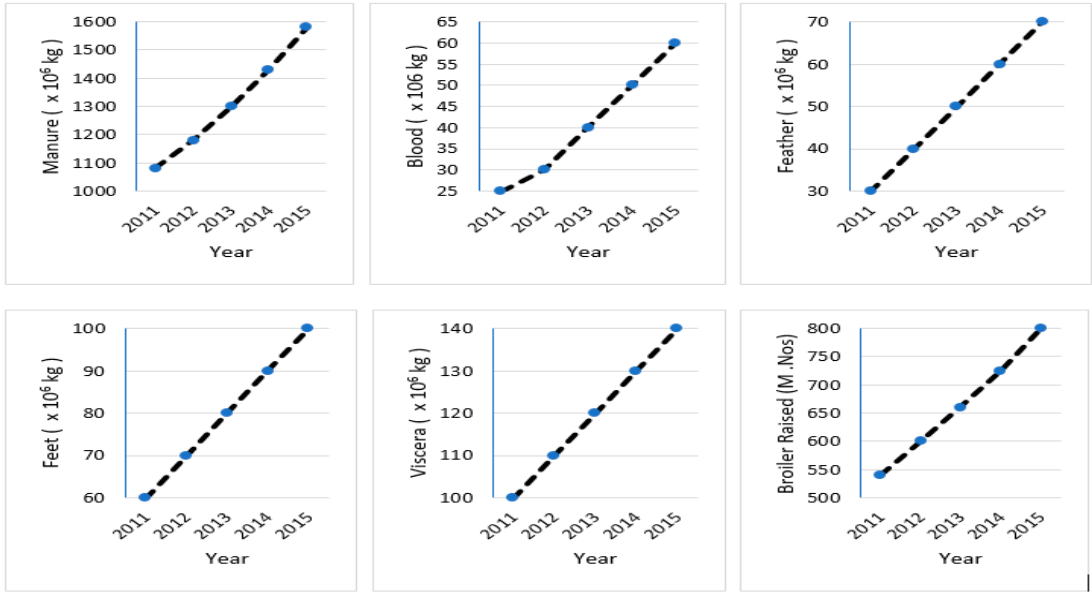
Figure 21. Waste produced in the poultry farms from 2011 to 2015.